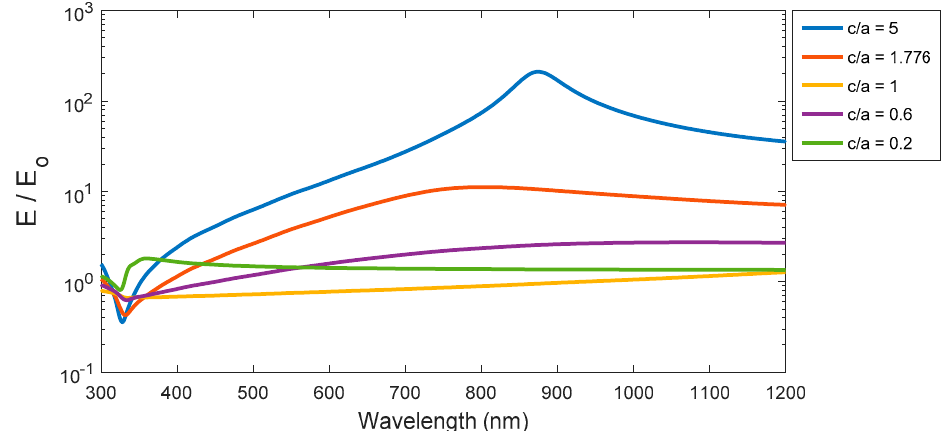
Figure 11. The enhancement factor (presented as logarithmic scale), for the ellipsoid, sphere, and the spheroid at different aspect ratios of elliptical structures.